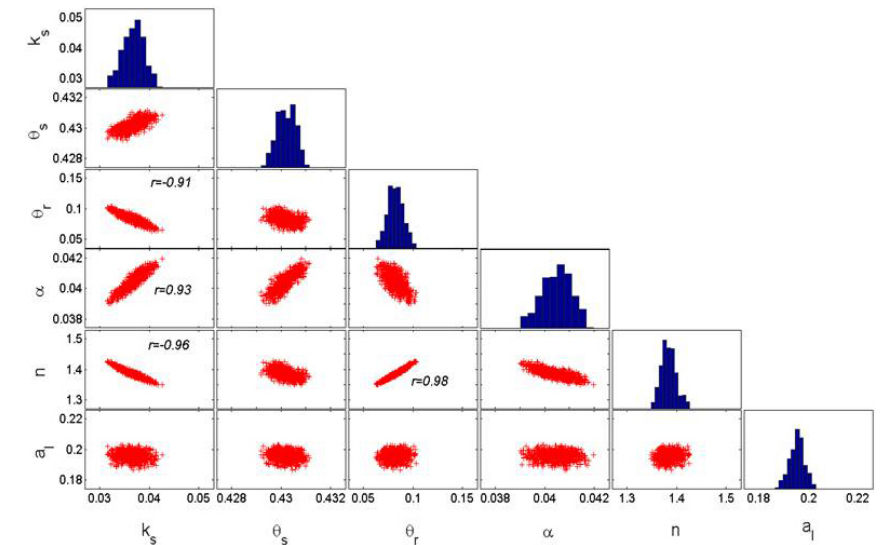
Figure 6. MCMC solutions for transport scenario 5 (see Fig. 2 caption).